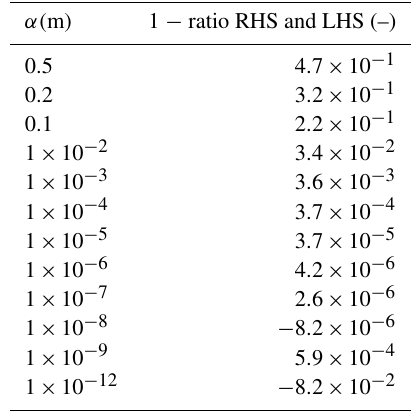
Table 1. A simple gradient test example involving the derivative of the 2m temperature with respect to the roughness length for heat ( z 0h ). The right column gives, for different values of perturbation α (m), the result of the calculation 1 − RHS divided by LHS, whereby RHS is the right-hand side of Eq. (25), and LHS is the left-hand side of the same equation. Note that only the RHS of the equation is influenced by α . In this example, we have only perturbed parameter z 0h , but multiple parameters can be perturbed within one